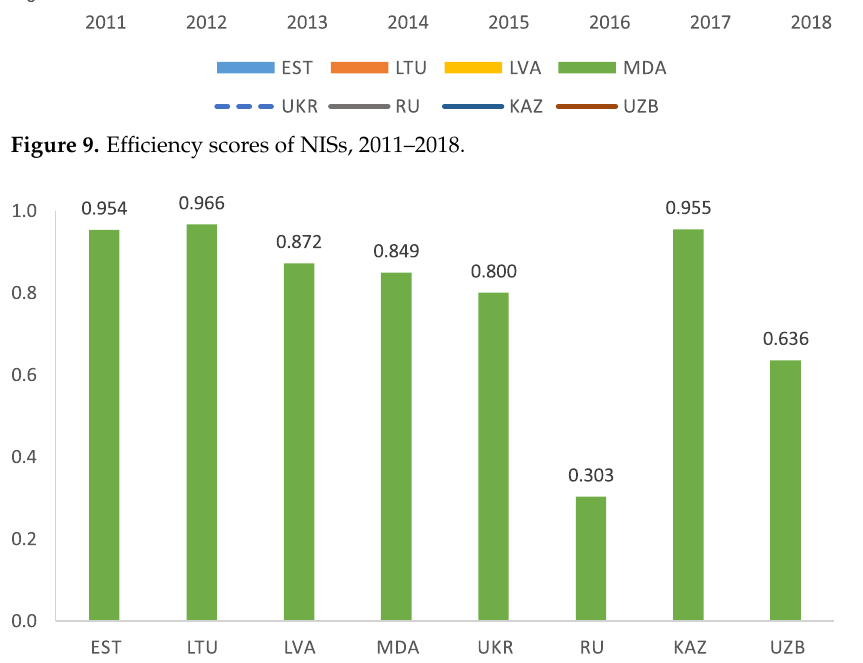
Figure 10. Mean efficiency scores of NISs in post-Soviet countries,